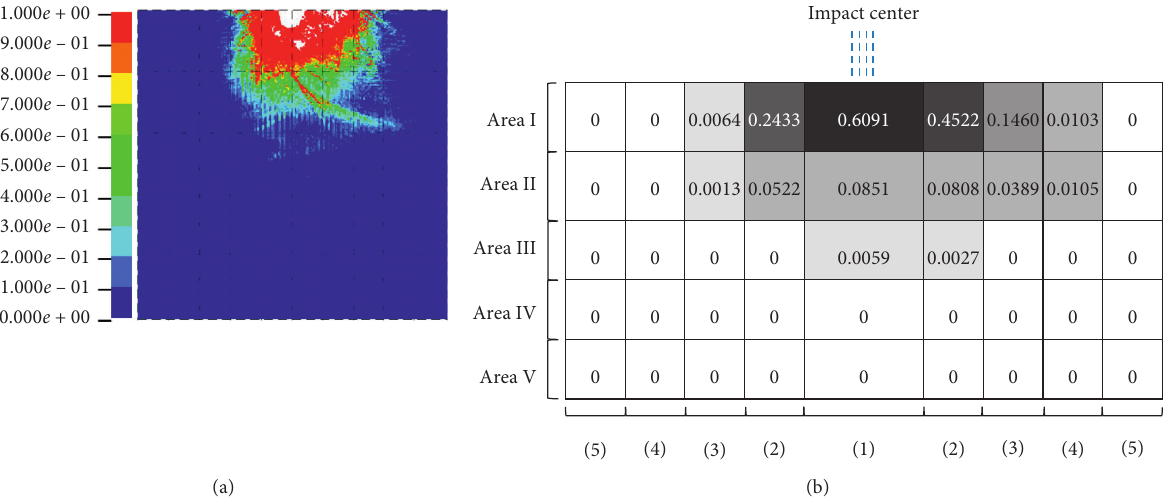
Figure 10: Distributions of comprehensive damage factors in each part of the ordinary concrete.